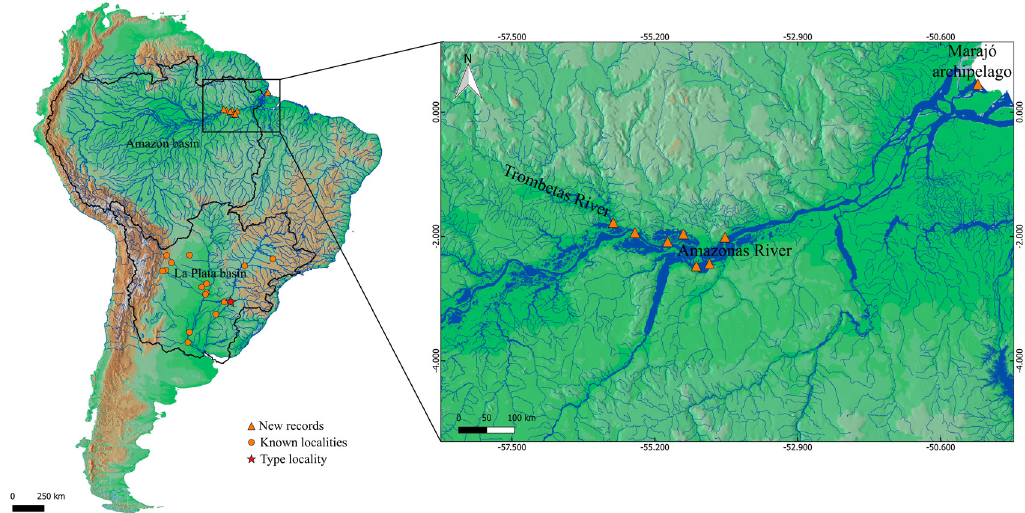
FIGURE 7 | Updated distribution map of Hoplias misionera showing former known localities in Argentina and southern Brazil (Rosso et al ., 2016) and the new records from Amazon basin (triangles). Star = type